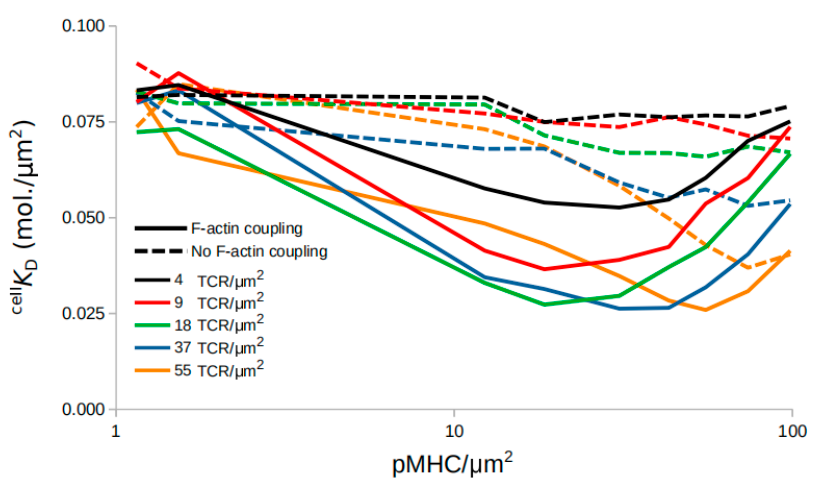
Figure 3. Affinity modulation during TCR and pMHC amount titration in the presence (solid lines) or absence (dashed lines) of complexes coupling to F-actin.